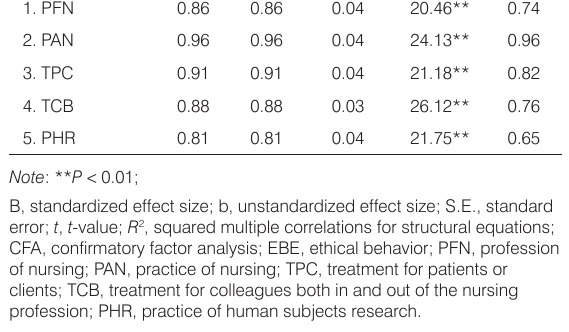
Table 2. Results of the second-order CFA on EBE and 5 sub- constructs.